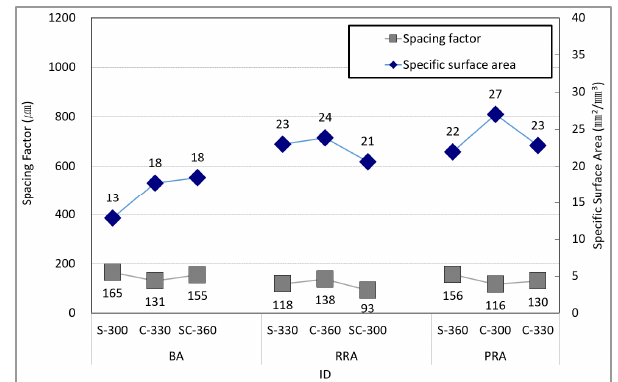
Figure 18. Relationship between the air content of fresh concrete and porosity of hardened concrete.